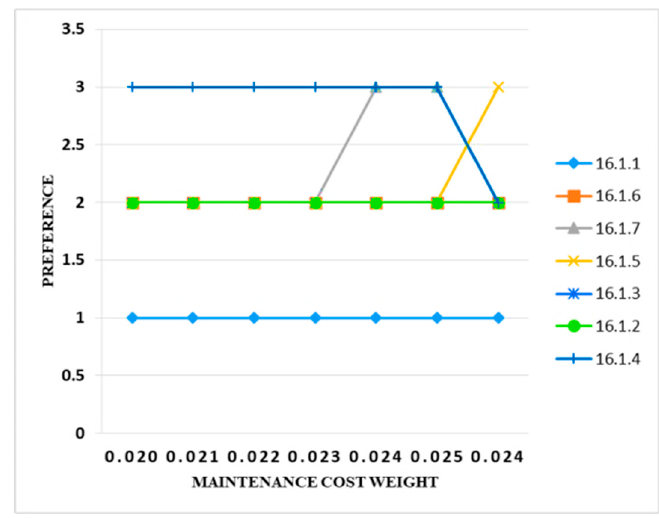
Figure 15. Sensitivity analysis of preference and maintenance cost weight.